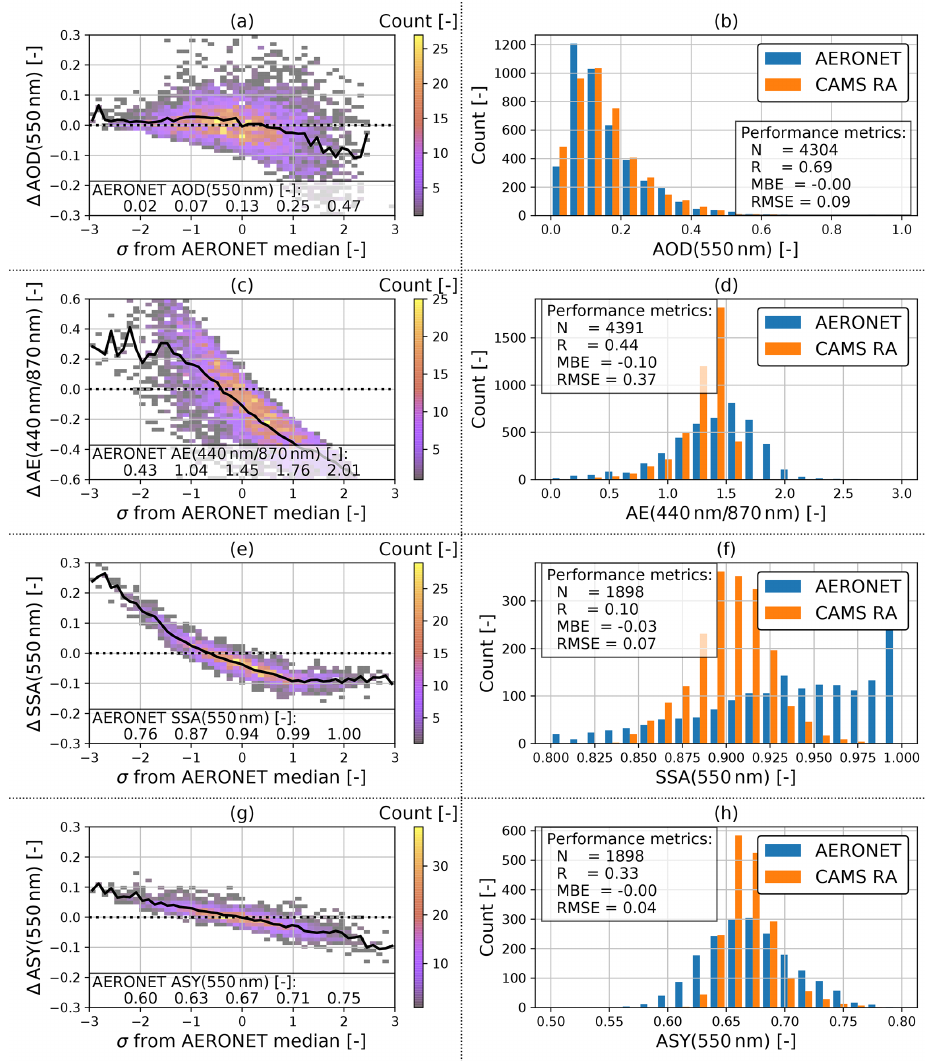
Figure D1. As Fig. 3 but with the comparison conducted exclusively for the year